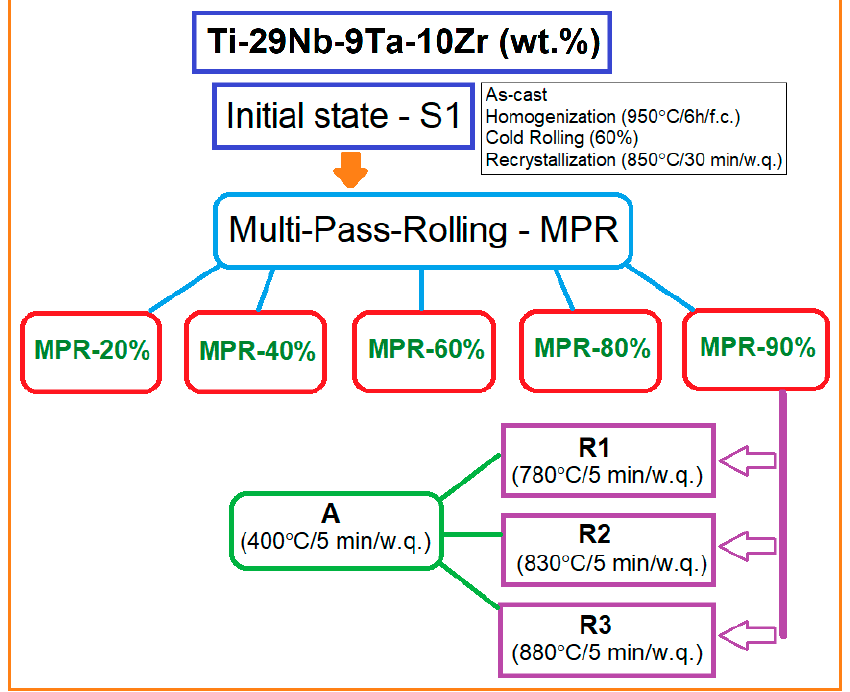
Figure 1. The experimental thermomechanical processing schema of the studied Ti-29Nb-9Ta-10Zr (wt %) alloy. (wt %)